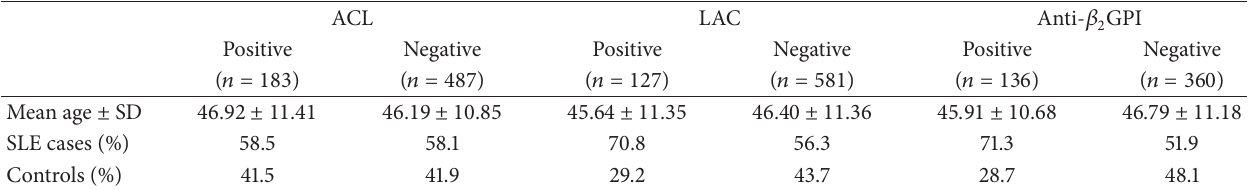
Table 1: Characteristics of study participants with three antiphospholipid antibodies in the GWAS dataset ∗ .